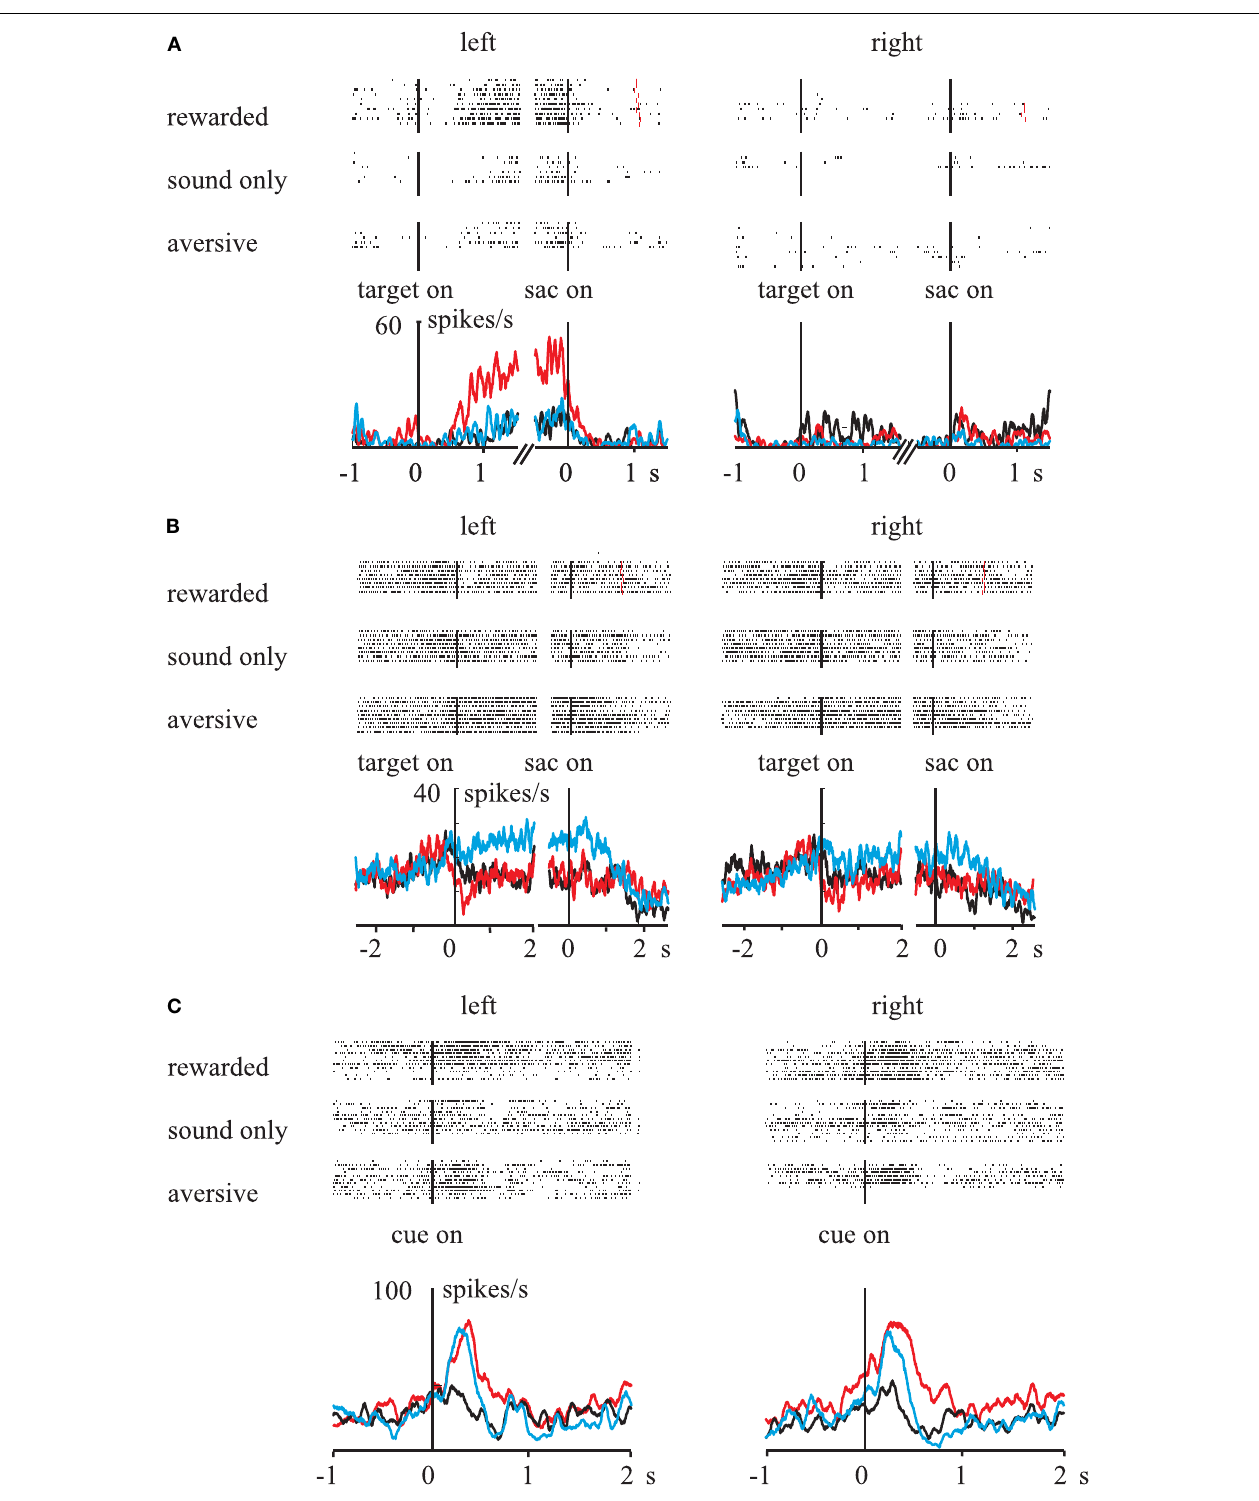
neuron increased during both rewarded and aversive trials, independent of the target cue location. Red line, rewarded trials; black line, neutral trials; blue line, aversive trials.Vertical lines indicate the onset of the events: target on, onset of the spatial cue for future saccade; sac on, saccade onset; cue on, onset of the reinforcement cue. Reprinted with permission from Neuron (Kobayashi et al.,